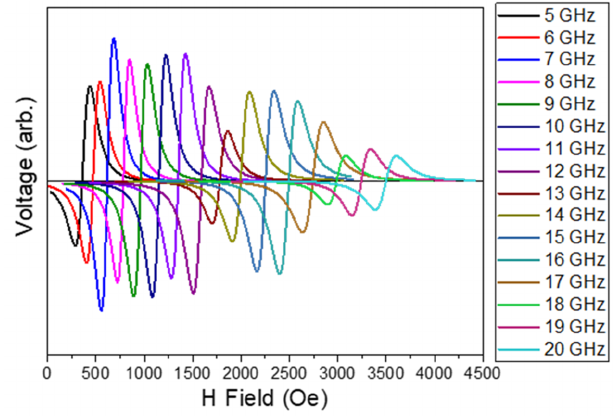
Figure 6. FMR analysis for sample S1.